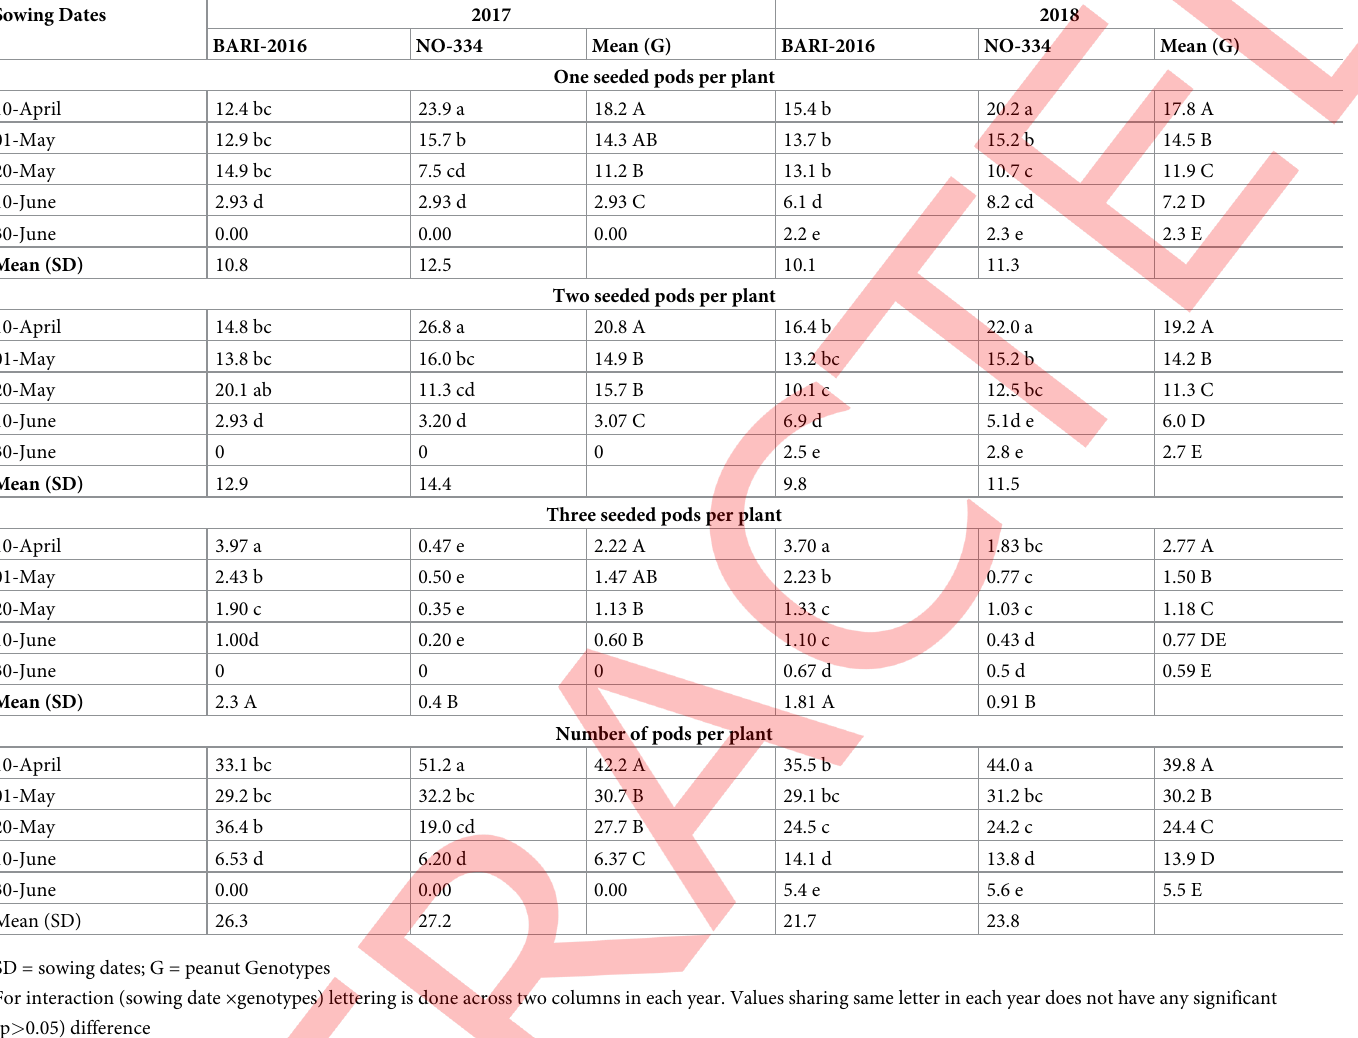
Table 1. Influence of sowing date and genotype on one, two and three seeded pods per plant under semi-arid subtropical climates (Layyah). Sowing